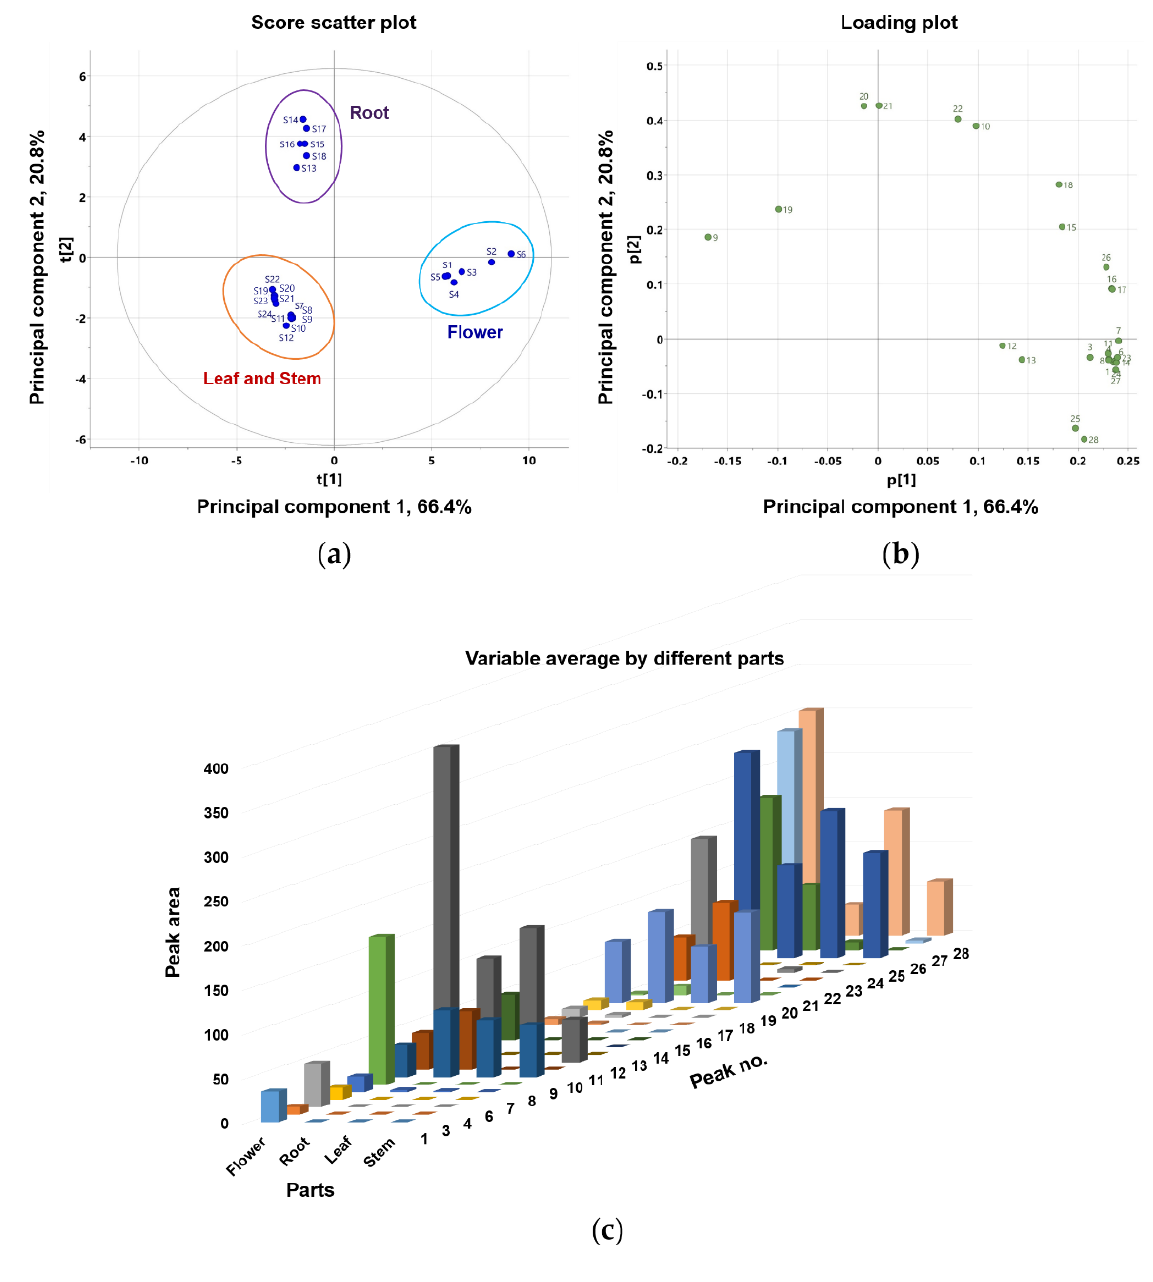
Figure 4. Principal component analysis (PCA) ( a ) score plot and ( b ) loading plot of the metabolome analysis of flower, root, leaf, and stem of P . japonicum ; ( c ) bar chart-showing the variable average for the different parts (flower, root, leaf, and stem) of P . japonicum .